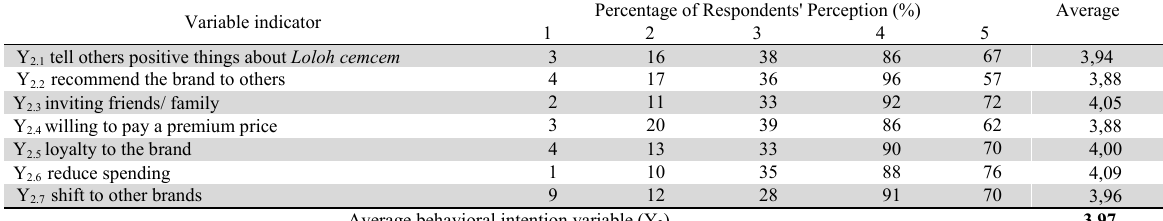
Description of Respondents' Perceptions of Behavioral intention Indicators (Y 2 )